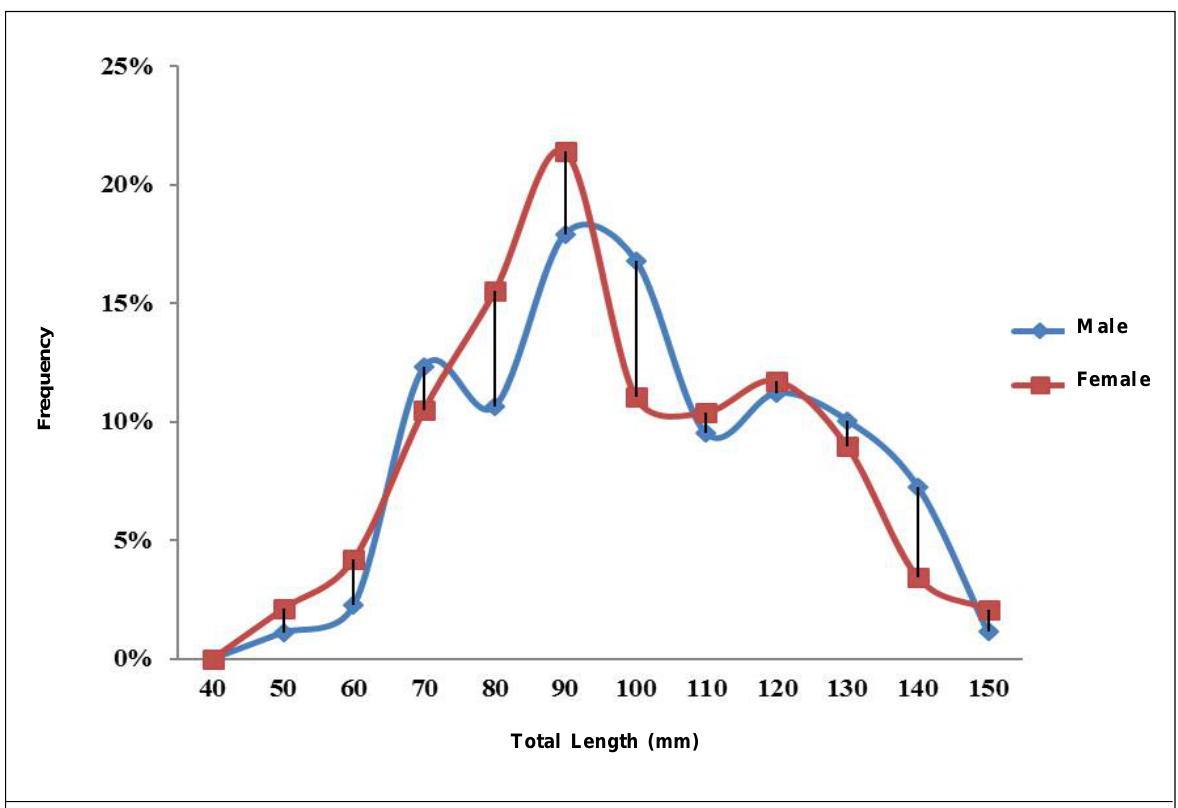
Figure 1: Length frequency distribution and size structure of population of M. vollenhovenii collected from Lower Volta River basin channel, Ghana over a period of two years